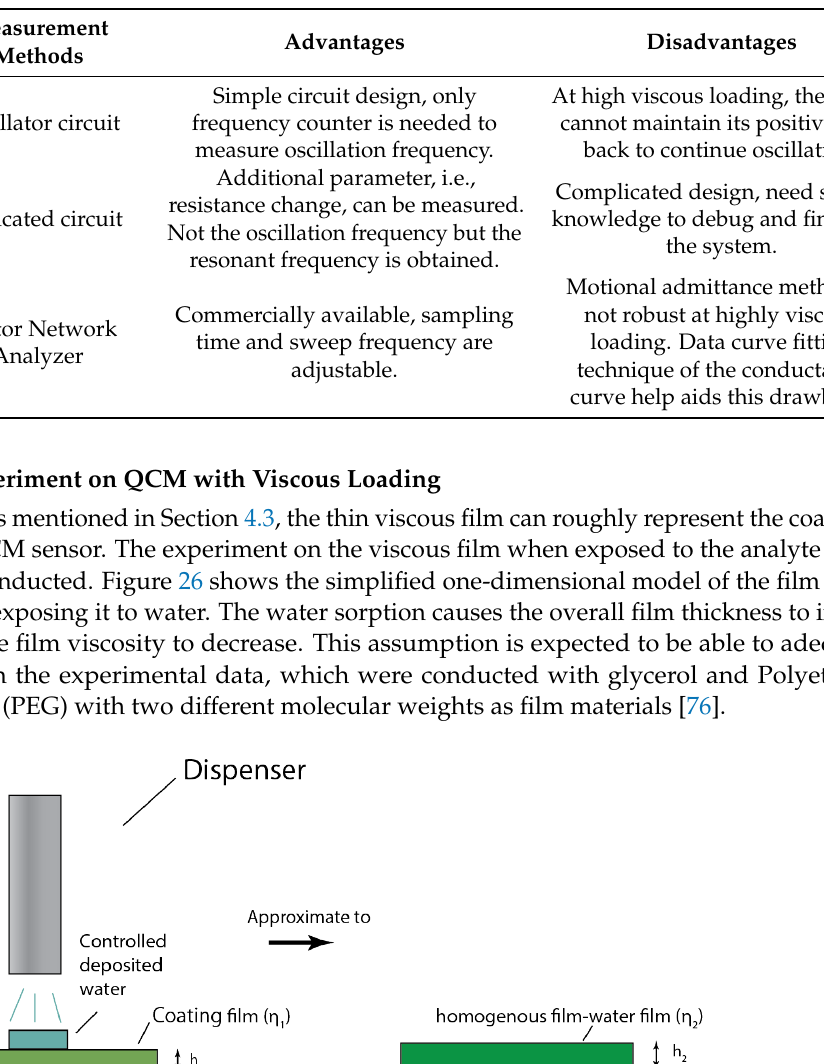
Table 3. Summary table of measurement methods.